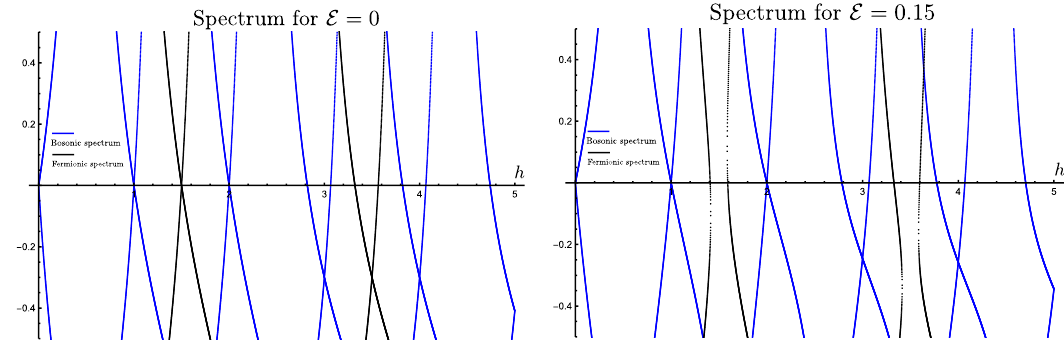
Figure 9 . The bilinear spectrum for E = 0 and 0 . 15 where each intersection with horizontal axis signifies an operator with dimension corresponding to the location of the intersection. The blue curve is bosonic and the black curve is fermionic. Note K thus all fermionic curves have multiplicity 2. In addition, the presence of pairs of lines comes from the spurious doubling of the spectrum due to unphysical local symmetries. Accounting for the unphysical modes, the E = 0 spectrum possesses the N = 2 Schwarzian multiplet with 2 h = 3 / 2 modes. Turning on the chemical potential leads to an IR theory with spontaneously broken supersymmetry. While the spectrum still organizes into multiplets, the 3 / 2 modes are no longer protected.